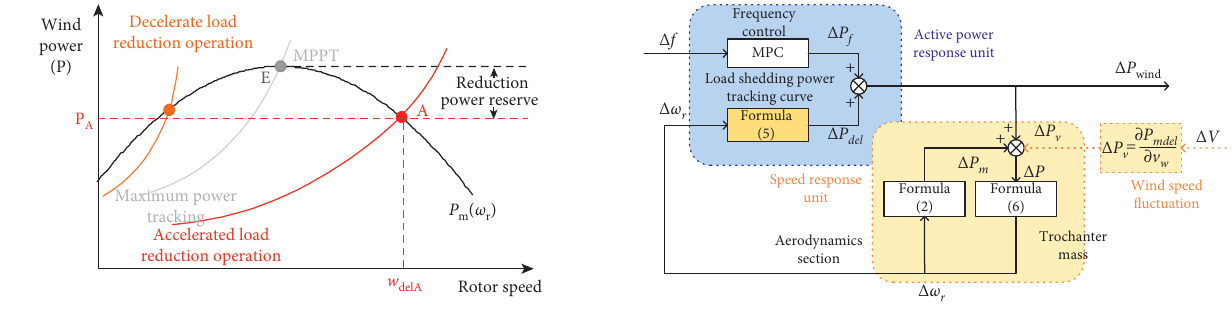
Figure 2: Structural block diagram of the fan frequency response model based on model predictive